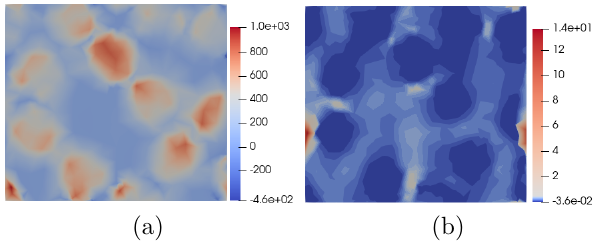
Figure 14. Basalt composite with maximal stiffness, time = 100 s: a) Shear stress [MPa], b) creep strain.